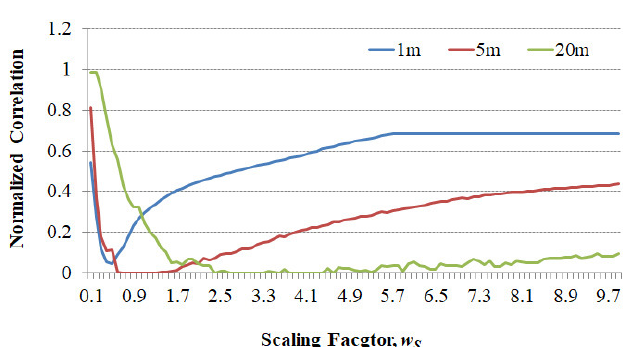
Figure 8. C (normal correlation) values according to the transform distance and scale factor of the second Fresnel transform in the proposed digital hologram encryption